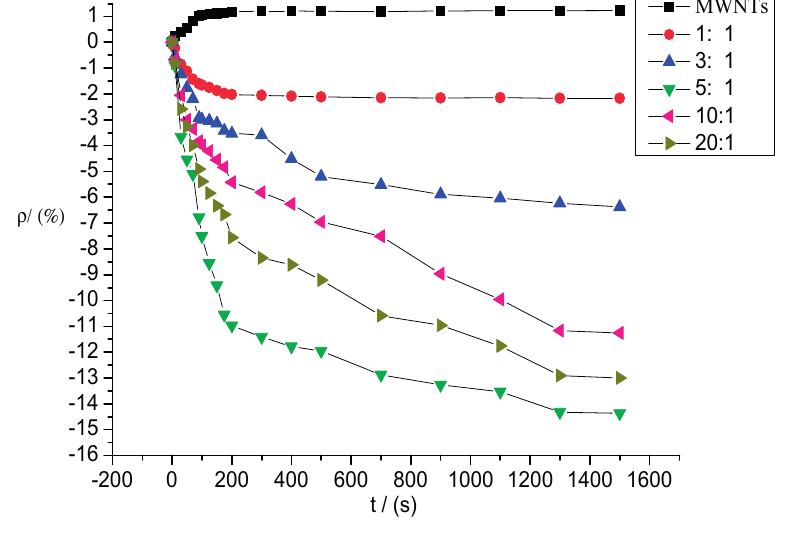
Figure 9. Response of MWNT sensor to SOF 2 at 100 ppm